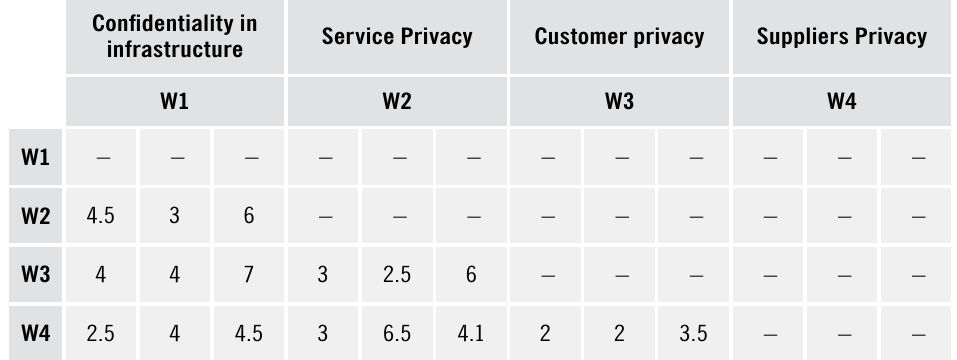
Table 6. Paired comparison matrix of security sub-criteria of privacy, based on experts